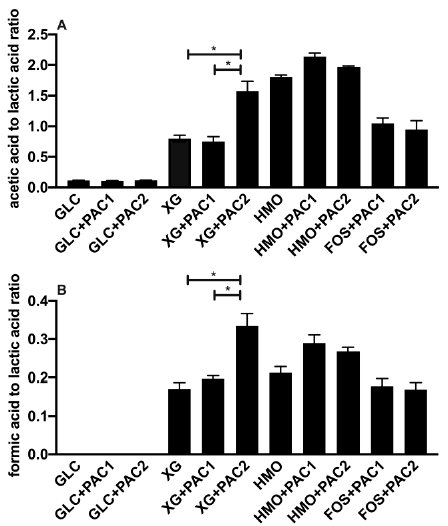
Figure 3. The ratio of fermentative end-products while utilizing oligosaccharides and cranberry PACs. Averages from independent biological triplicates with standard deviation of the mean of the acetic acid-to-lactic acid ratio ( A ) and formic acid-to-lactic acid ratio ( B ). Asterisks represent the significant difference evaluated by ANOVA and Tukey’s multiple comparisons test ( p < 0.05).